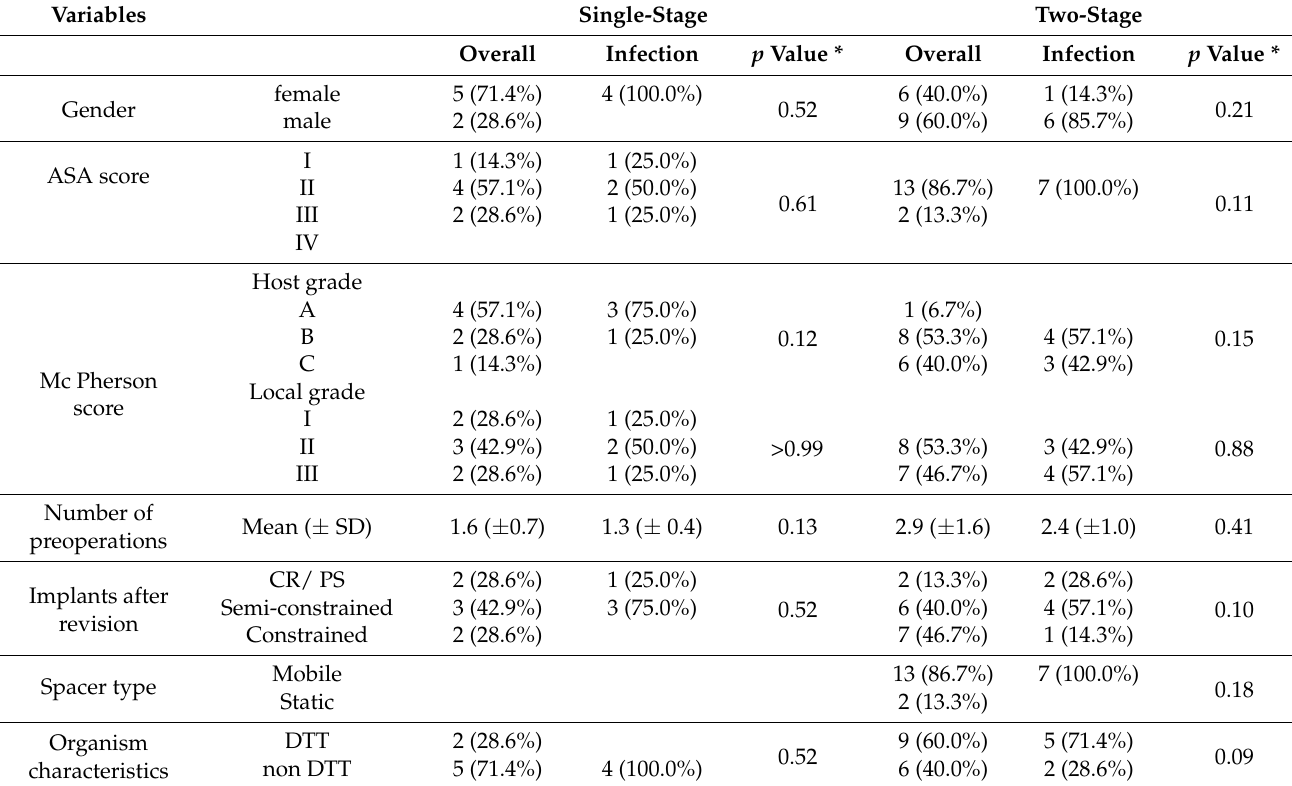
Table 4. Variable analysis on revision